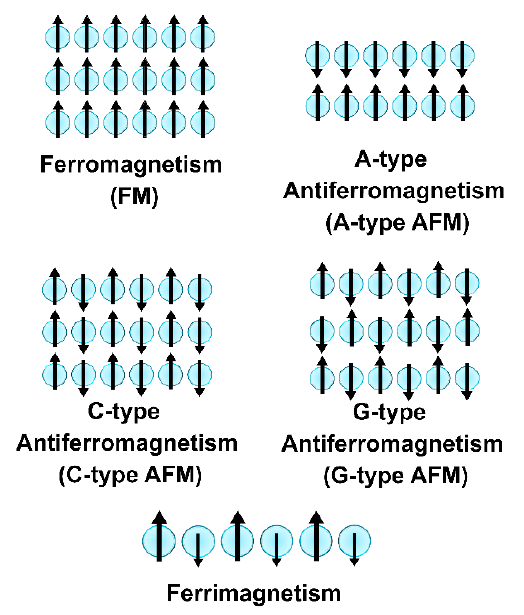
Figure 2. Scheme describing ferromagnetism, antiferromagnetism (most common types) and ferri- magnetism. The direction and the verse of the spins (atomic magnetic moments) are shown as black arrows. This is a simple scheme showing only one unpaired electron per atom, for clarity.